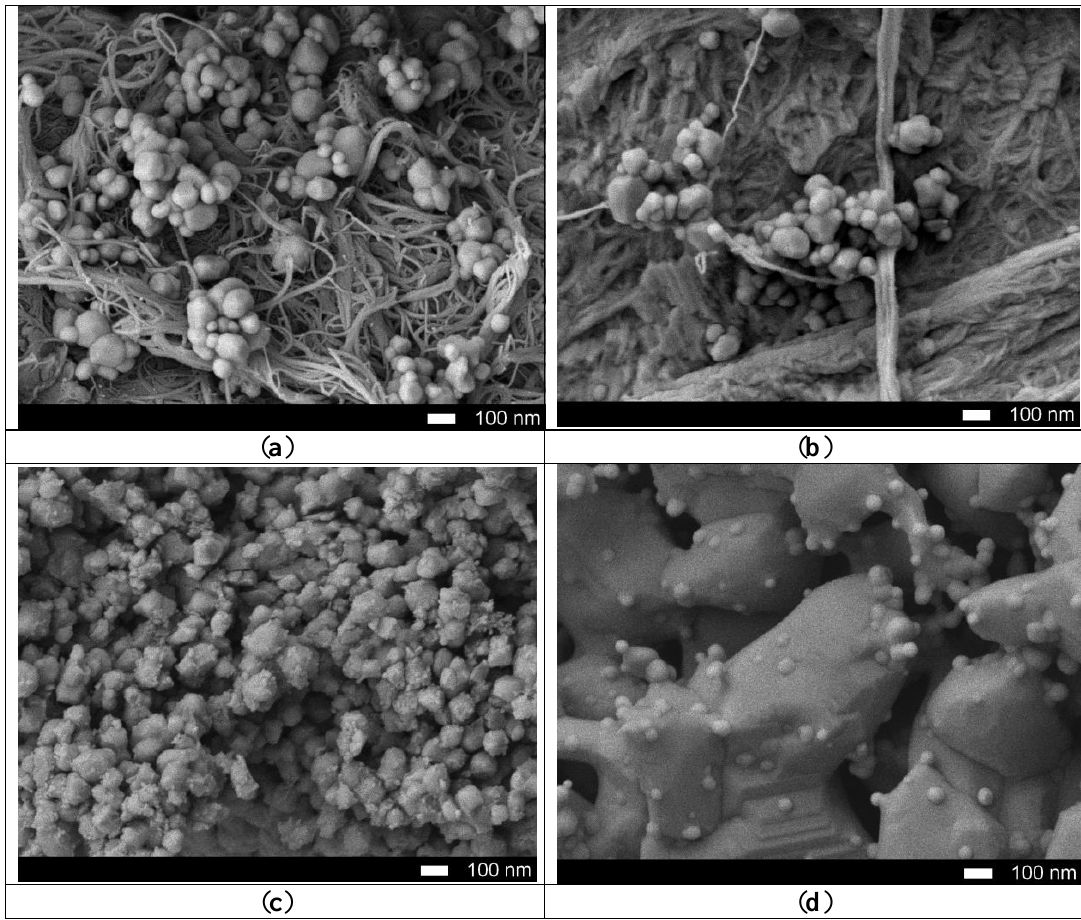
Figure 1. SEM images of synthesized nanostructured ceramics Y 2 O 3 /TiO 2 -Y 2 TiO 5 doped CNTs: ( a ) 25 °С; ( b ) 600 °С; ( c ) 800 °С; ( d ) 1000 °С.